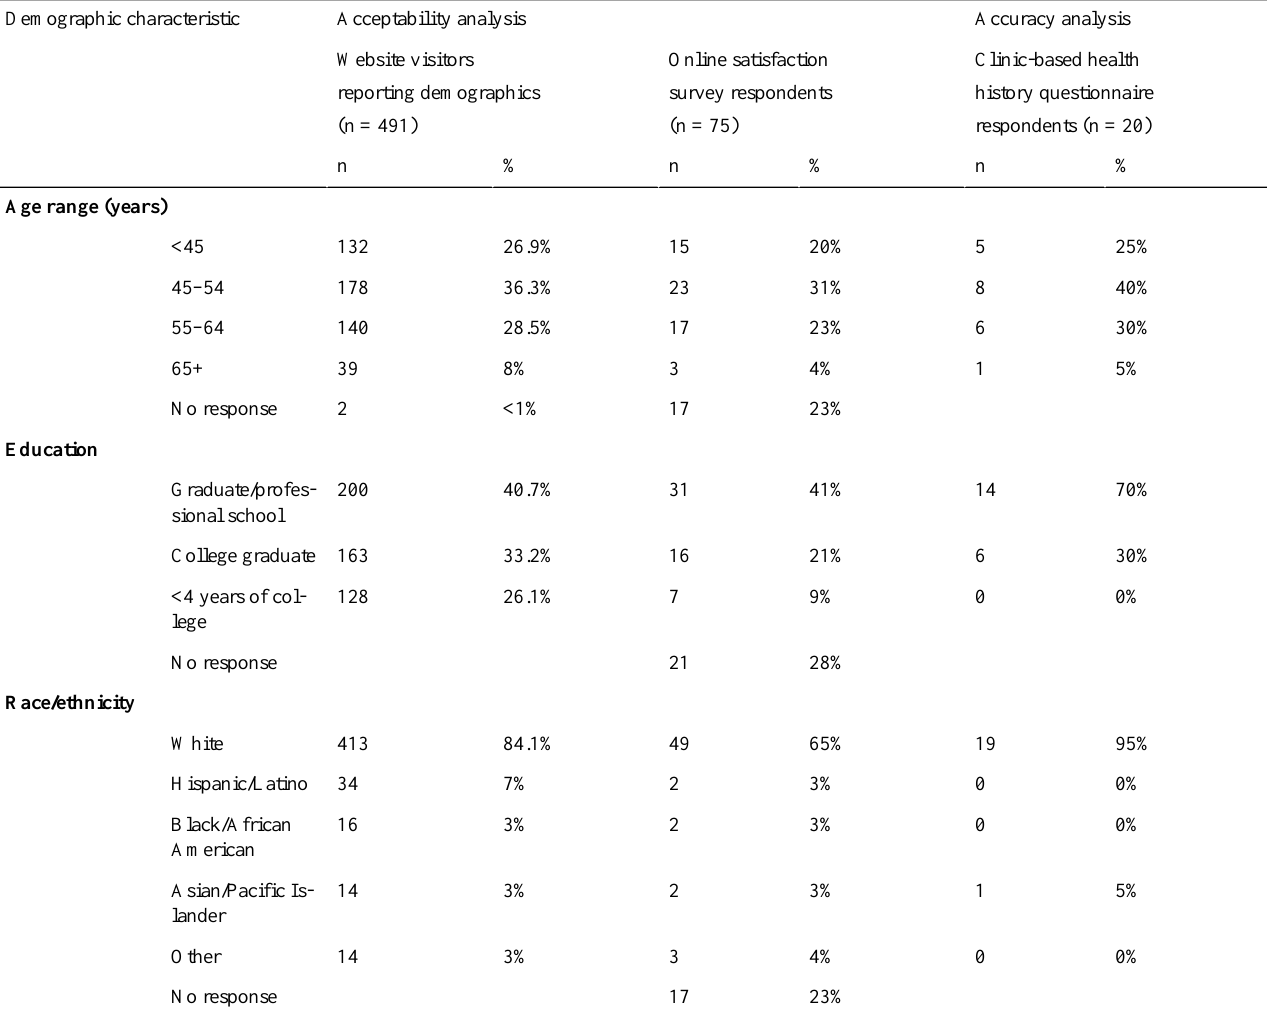
Table 2. Demographics characteristics of respondents to acceptability and accuracy study